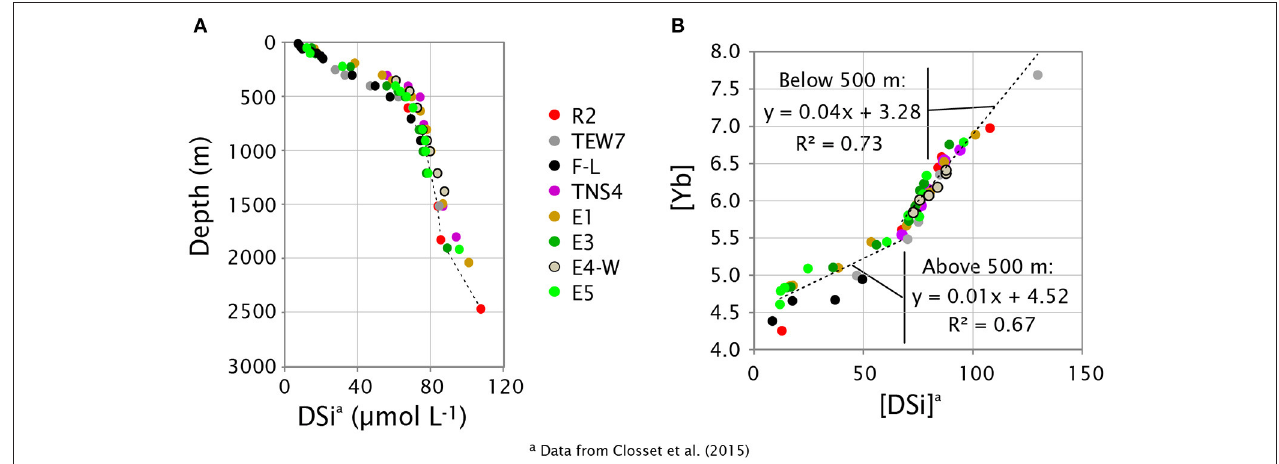
FIGURE 10 | (A) Vertical profiles of the H4SiO4 concentrations (DSi, in µ mol L − 1 ; from Closset et al., 2014) of the deep and meander stations; (B) Relationships between Yb concentrations (in pmol kg − 1 ) and DSi concentrations (in µ mol L − 1 ) of these same stations, excluding the samples tagged by lithogenic signatures. Two linear regressions are given to characterize the distribution above and below 500m depth, which corresponds to the slope break depth of the [DSi] vertical profile shown in (A) .